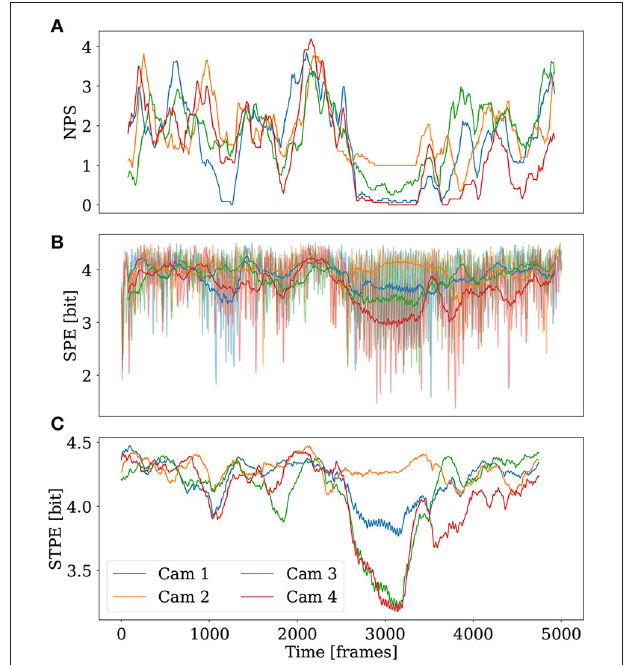
FIGURE 7 | NPS, SPE, and STPE for the four different cameras of the 3D simulation. The spatial separation was fixed to L x = 14. (A) NPS, smoothed with a running average filter with a width of 155 frames. (B) The raw SPE time series are displayed transparently in (B) in the background. Smoothed time series of SPE are plotted in the foreground. A running average filter with a width of 155 frames has been used. (C) shows the STPE time series.